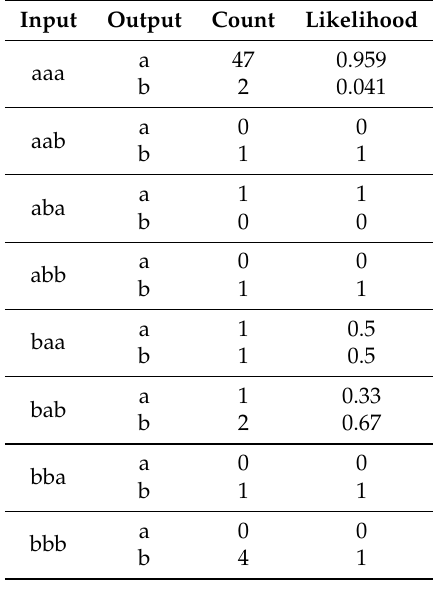
Table 4. Rule for the sequence and mask using a subset of 3000 points restricted to 3:00 p.m. ( a -unoccupied, b